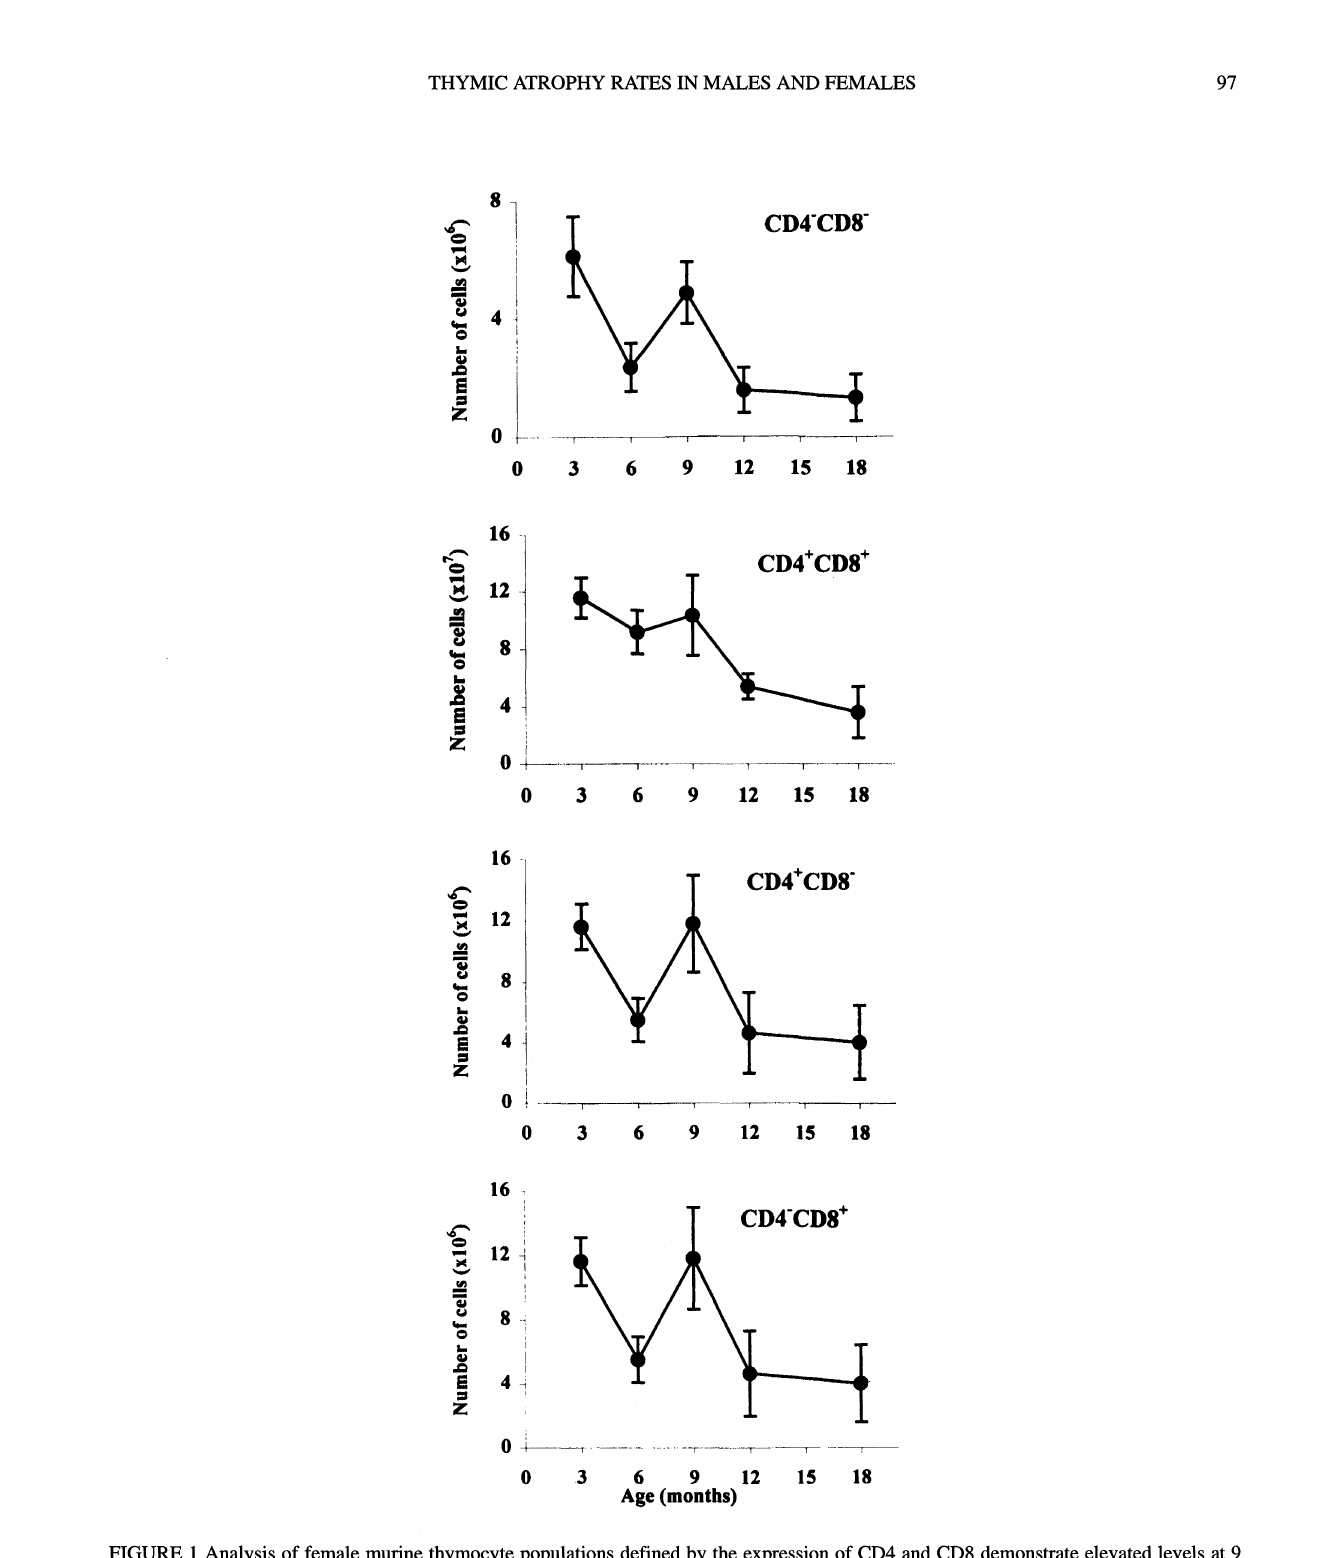
FIGURE Analysis of female murine thymocyte populations defined by the expression of CD4 and CD8 demonstrate elevated levels at 9 months of age (n=3-7 animals at each time point). After this time there is a rapid decline in all subpopulations at 12 and 18 months of